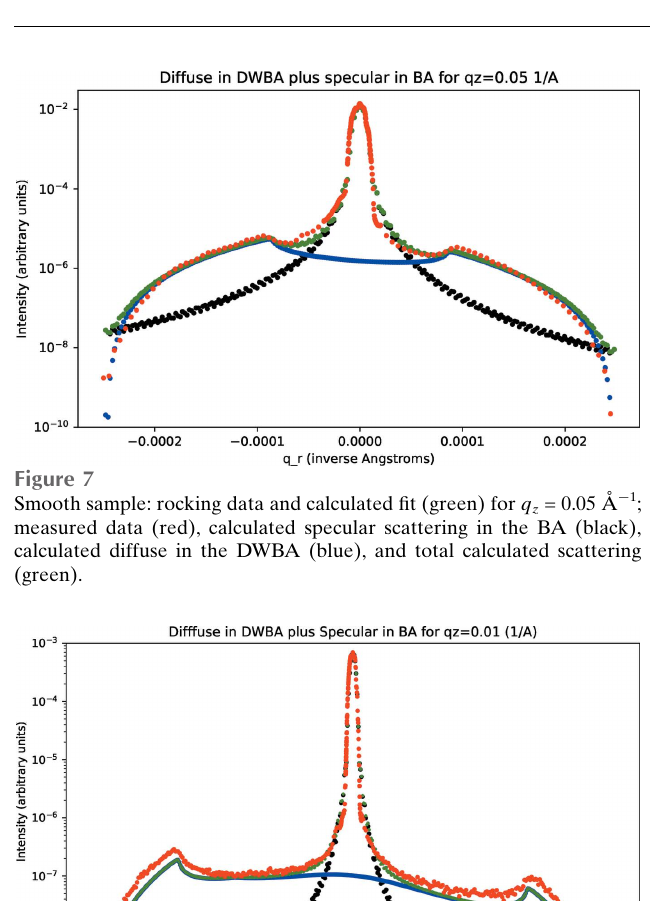
Table 1. The DWBA simulated results were scaled to optimize the agreement between the total simulated scattering (spec- ular plus diffuse) and the measured data.